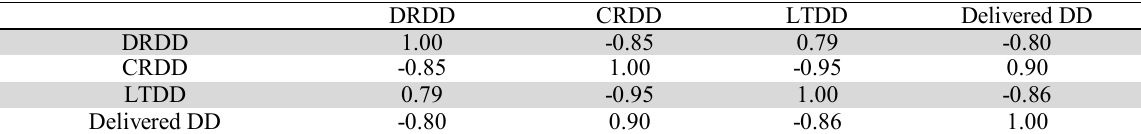
Correlation matrix